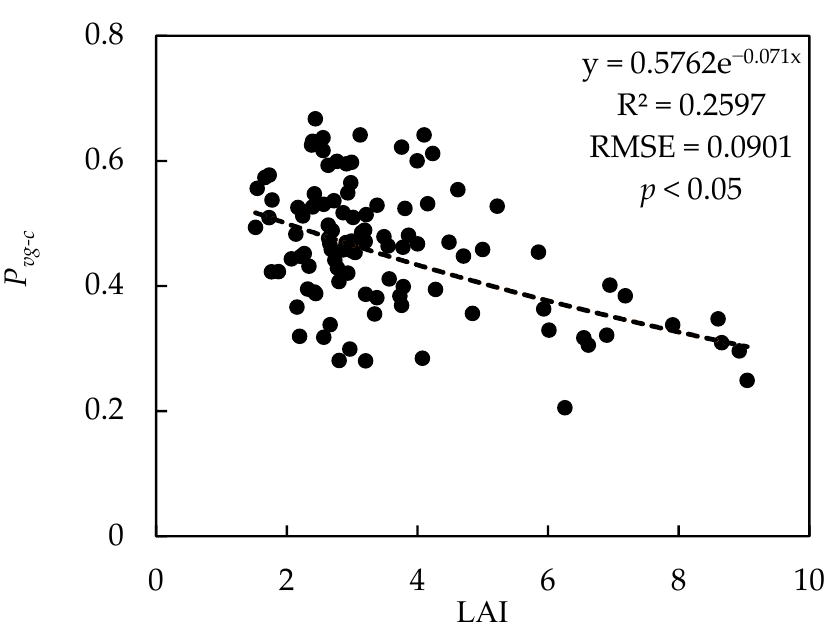
Figure 6. Scattering plot between P vg-c and LAI.